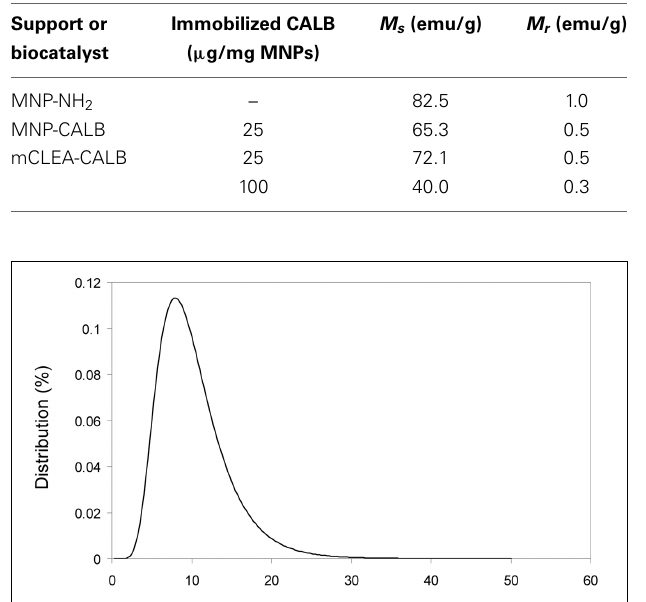
Table 1 | Magnetic parameters of MNP-NH 2 and biocatalysts obtained of CALB.